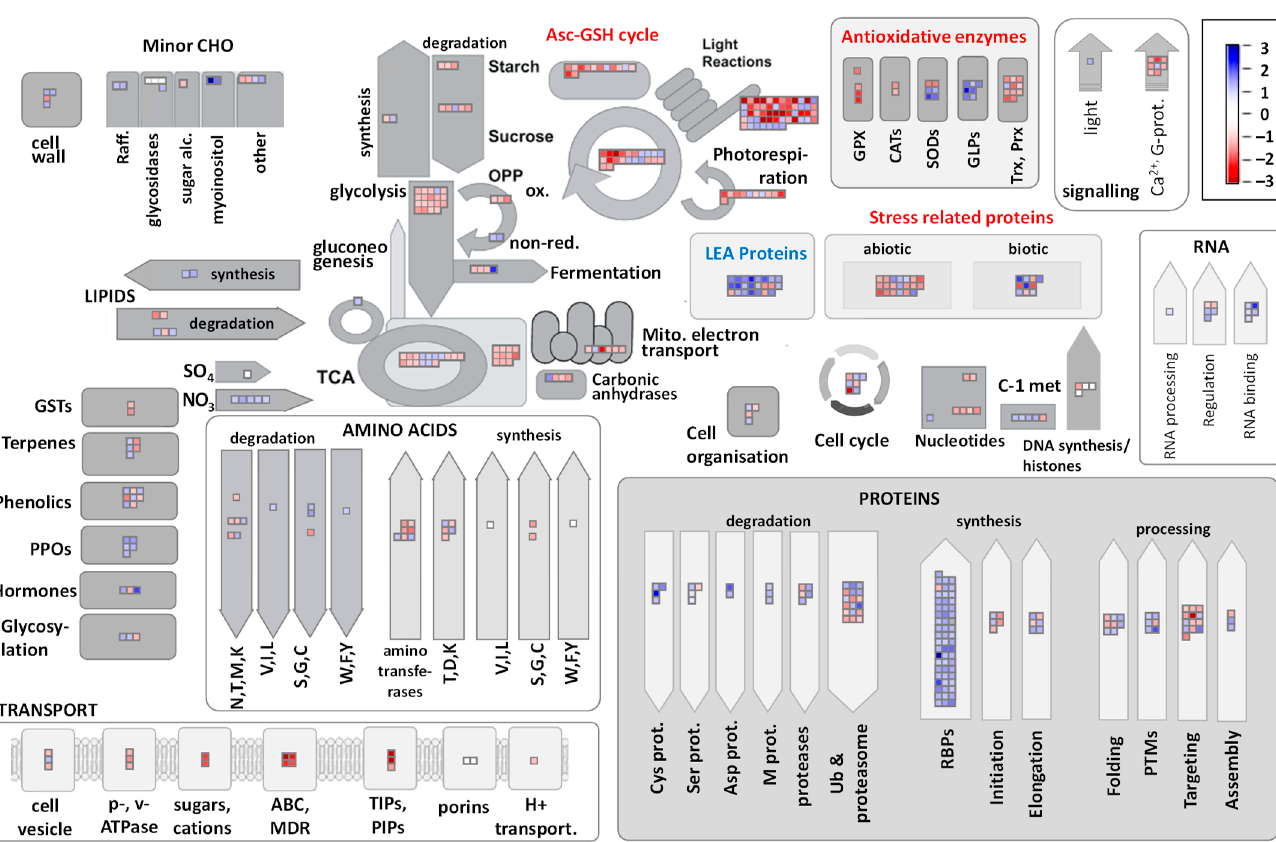
Figure 4. Mapman display of differentially abundant proteins (DAPs) in DL vs. HL, manually mapped according to TAIR mapping. Accumulated proteins in DL are indicated in blue, and accumulated proteins in HL are shown in red. AAs, amino acids; ABC, ATP-binding cassette transporters; Asc, ascorbate; CAT, catalase; CHO, carbohydrates; GLPs, germin-like proteins; GSH, reduced glutathione; GSTs, glutathione-S-transferases; MDR, multidrug resistance transporters; OPP, oxidative pentose-phosphate pathway; PIPs, plasma membrane intrinsic proteins; PPOs, polyphenol oxidases; Prx, peroxiredoxins; PTMs, post-translational modifications; ox-red, oxidoreductases; RBPs, ribosome-binding proteins; TCA, tricarboxylic acid cycle; TIPs, tonoplast intrinsic proteins; Trx, thioredoxins; Ub, ubiquitin; CHO, carbohydrates.